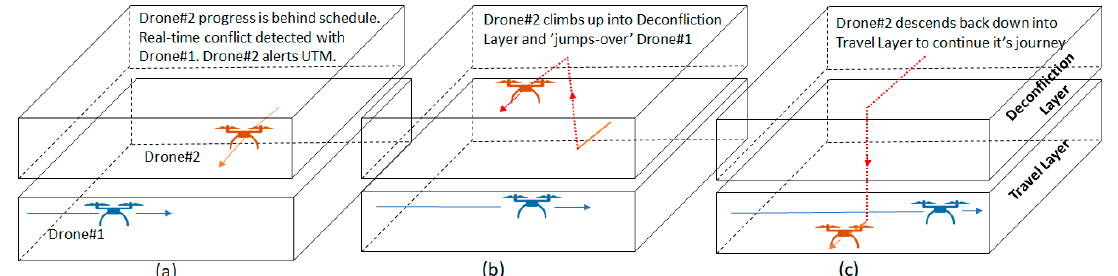
Figure 15. Tactical deconfliction sequence: orange drone originally operating clear of new blue drone which has just joined UTM, but orange drone is now running behind predicted schedule and alerts UTM ( a ); UTM examines the paths and instructs delayed orange drone to jump over blue drone in order to avoid traffic conflict ( b ); orange drone descends back down into travel layer and continues on journey ( c ).